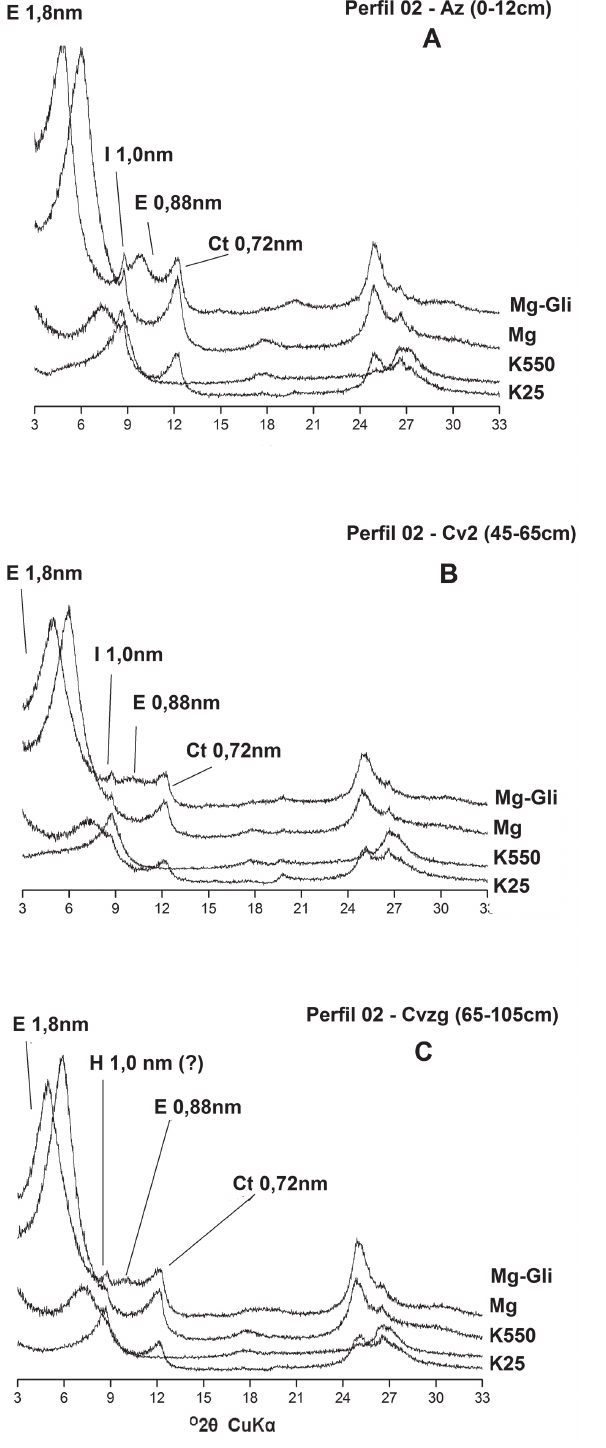
Figura 4. Difratogramas de raios-X da fração argila do perfil 02 - VXz gleissólico (E-esmectita; I-ilita; Ct-caulinita; e